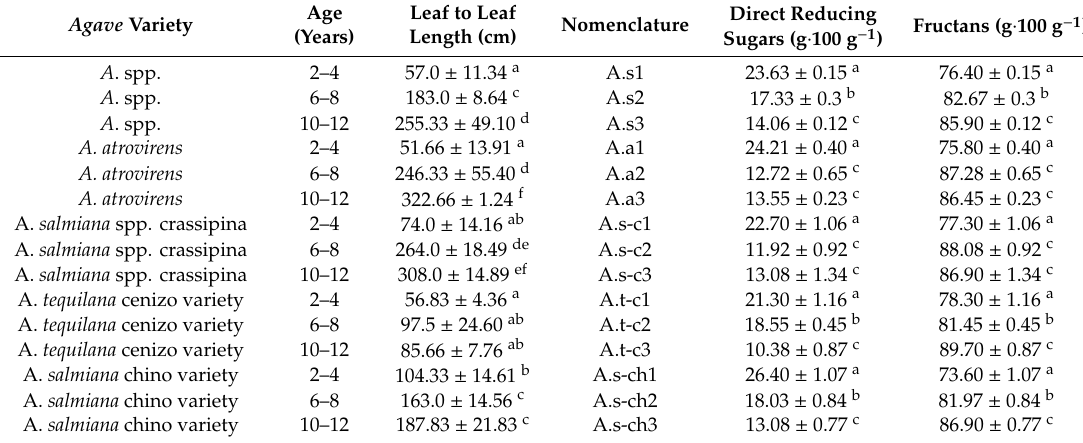
Table 1. Sugar content of five wild agave varieties at three di ff erent